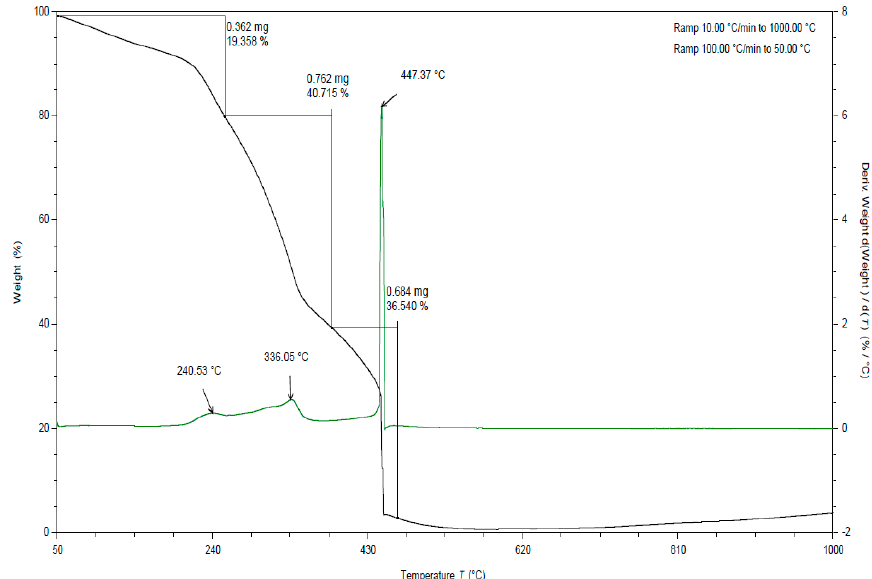
Figure 8. TGA curves for apple pomace dried to dry weight. Analysis in an oxygen atmosphere (black line is a curve of mass loss versus temperature, green line is the first derivative).